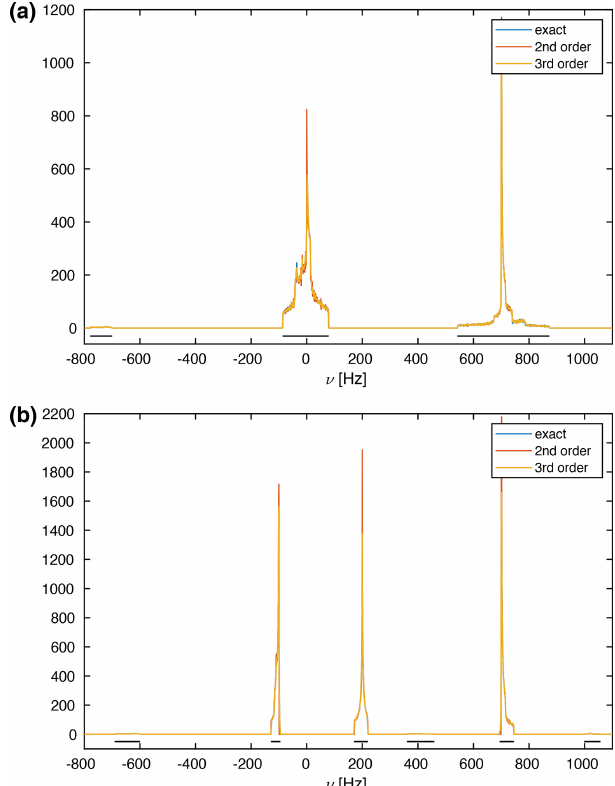
Figure 5. Calculated MAS spectra of a three-spin system at an MAS frequency of 100kHz. The spin-system parameters are δ 12 / (2 π ) = − 44826Hz, δ 13 / (2 π ) = − 8898Hz, δ 23 / (2 π ) = − 5750Hz, θ = 90 ◦ , θ = 120 ◦ . The spectral window was set 13 23 to 20kHz with 20000 data points leading to a digital resolution of 1Hz. One hundred thousand powder points were sampled ac- cording to the ZCW scheme (Cheng et al., 1973). The chemical shifts were chosen to be (a) δ 1 = δ 2 = 0ppm, δ 3 = 0.7ppm and (b) δ 1 =− 0 . 1ppm, δ 2 = 0.2ppm, δ 3 = 0.7ppm at a Larmor fre- quency of 1GHz. The black line under the spectra indicates regions of